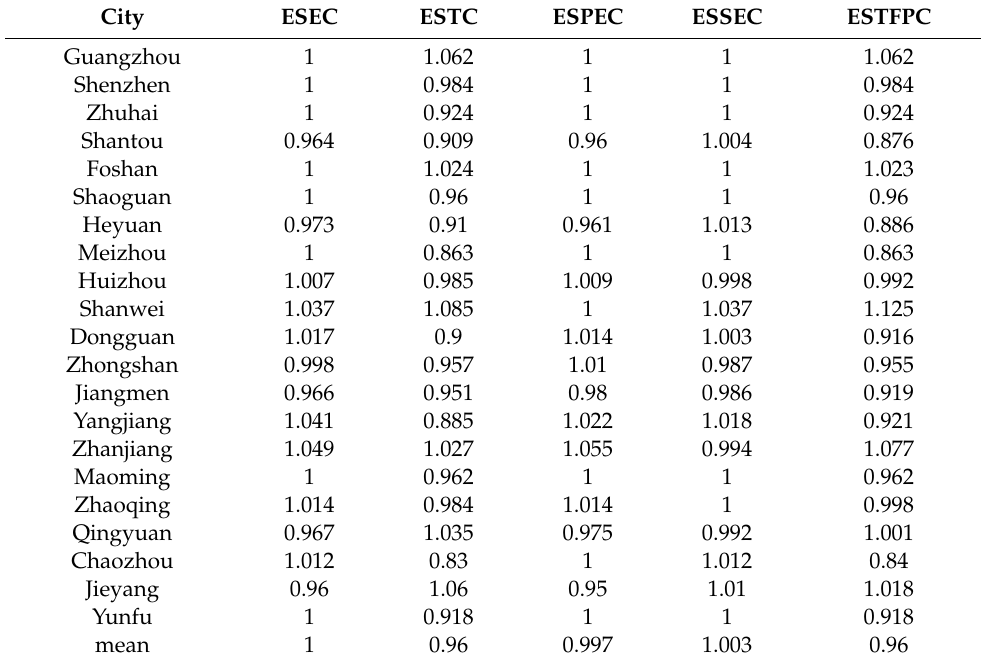
Table 4. E ffi ciency Change and Decomposition.